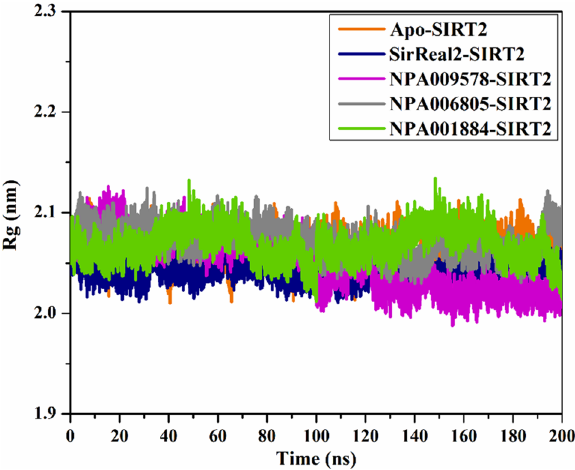
Figure 11. Radius of gyration (Rg) of apo and ligand-soaked SIRT2 protein throughout 200 ns MD simulation. Color Scheme: Apo SIRT2 (in orange), SirReal2-SIRT2 (in navy), NPA009578-SIRT2 (in pink), NPA006805- SIRT2 (in gray), and NPA001884-SIRT2 (in green).